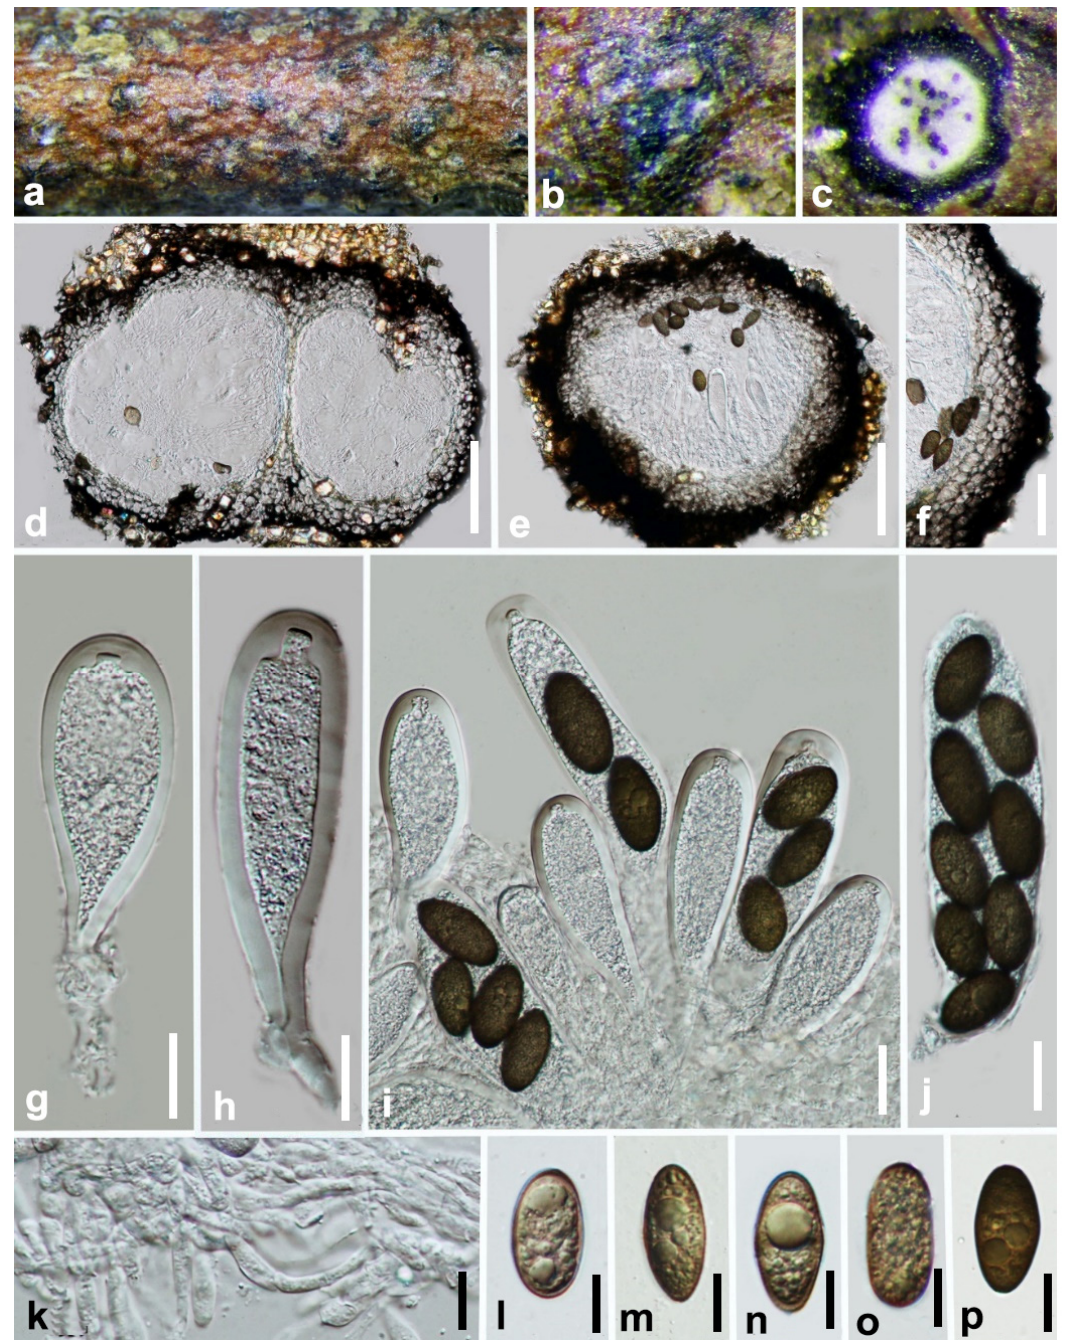
Figure 3. Barriopsis tectonae (GZAAS 19-1985). ( a , b ) Appearance of ascomata on wood. ( c ) Horizontal section of the ascomata. ( d , e ) Vertical section of ascomata. ( f ) Peridium. ( g , h ) Immature asci. ( i ) Immature and mature asci. ( j ) Mature asci. ( k ) Pseudoparaphyses. ( l – p ). Brown ascospores. Scale bars: ( d ) = 50 µm, ( e ) = 100 µm, ( f ) = 50 µm, ( g – j ) = 20 µm, ( k – p ) = 10 µm.